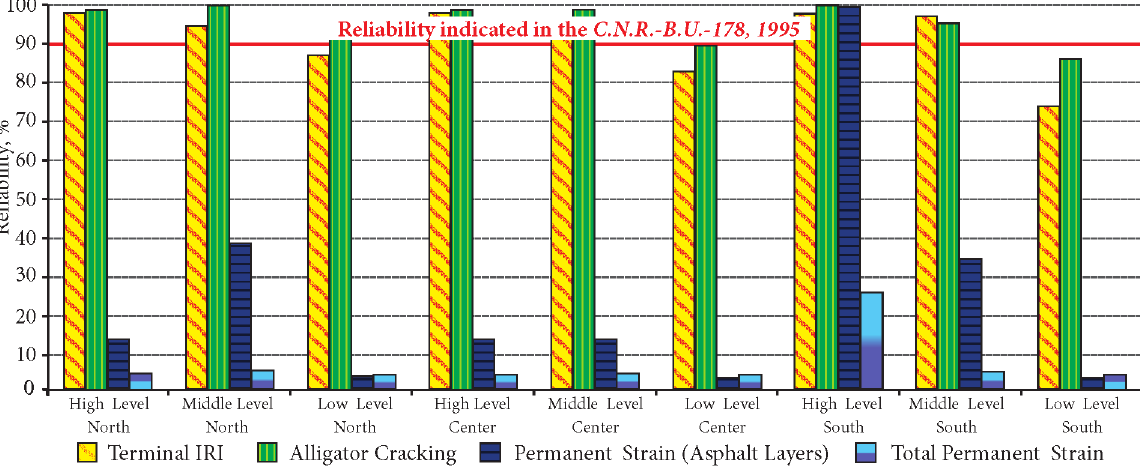
fig. 7. Decay of the pavement – freeway/semi-rigid pavement after 20 years